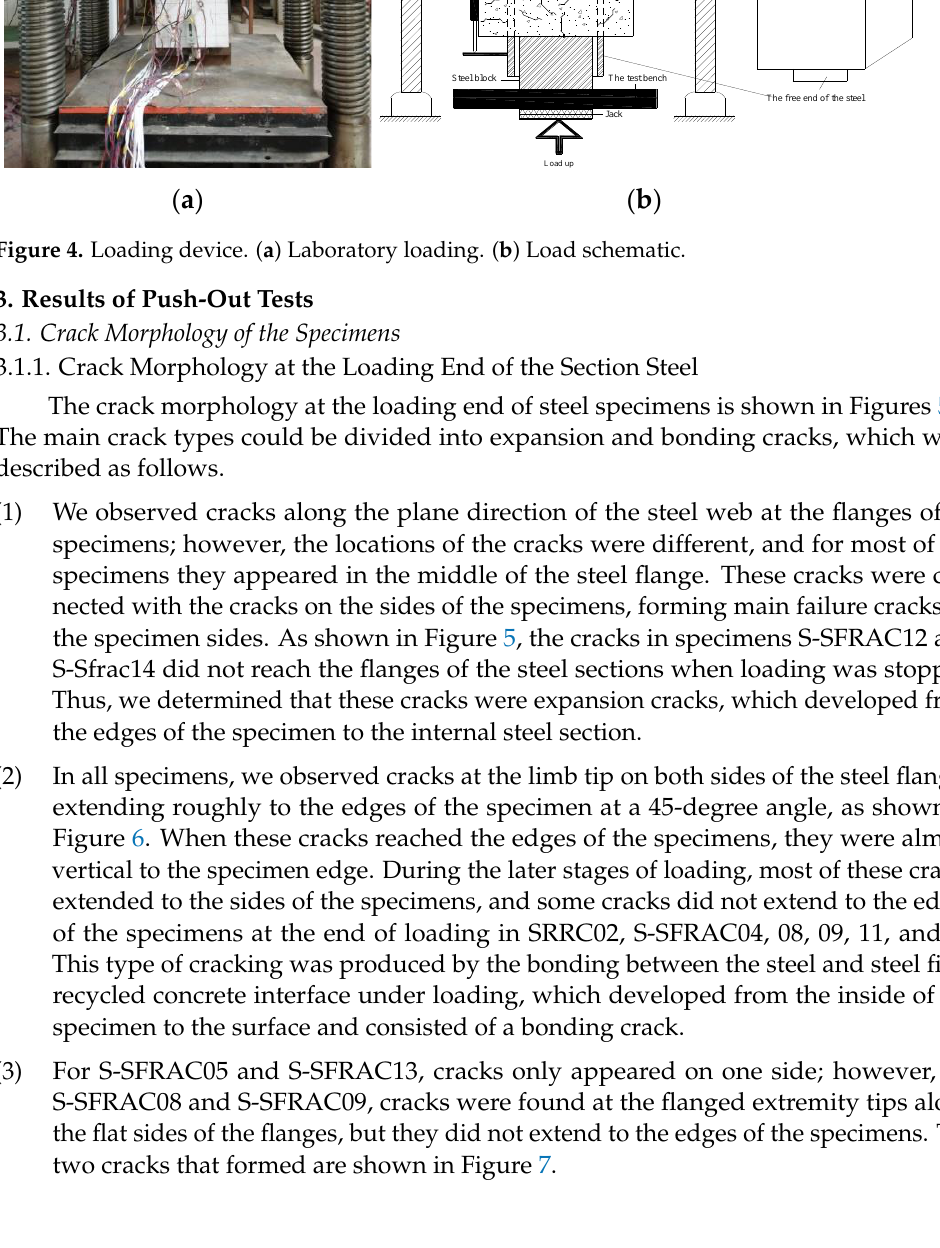
Figure 5. Expansion cracks. ( a ) S-SFRAC12. ( b ) S-SFRAC14.